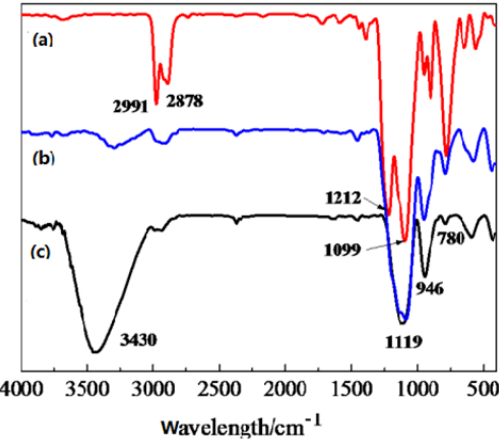
Figure 1. FT-IR spectra of ( a ) FVPS, ( b ) FSi@SiO 2 , and ( c ) SiO 2 sol.